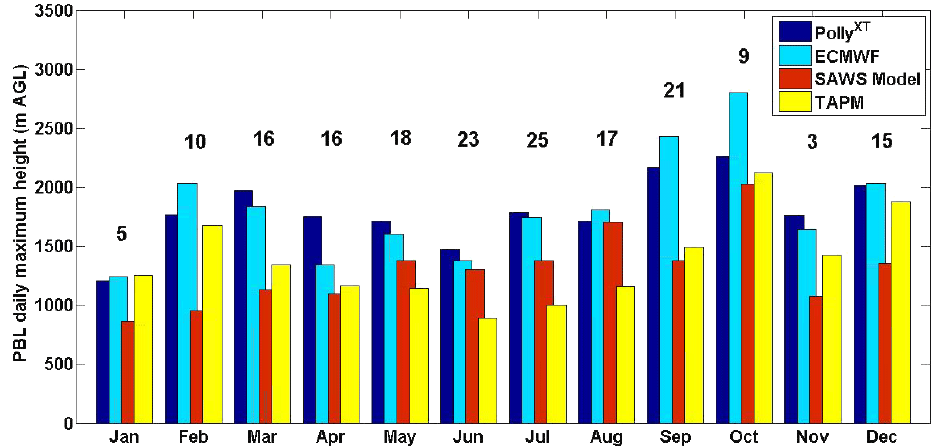
Fig. 5. Monthly averages of PBL daily maximum values. Numbers above bars indicate the number of measurement days on each month.